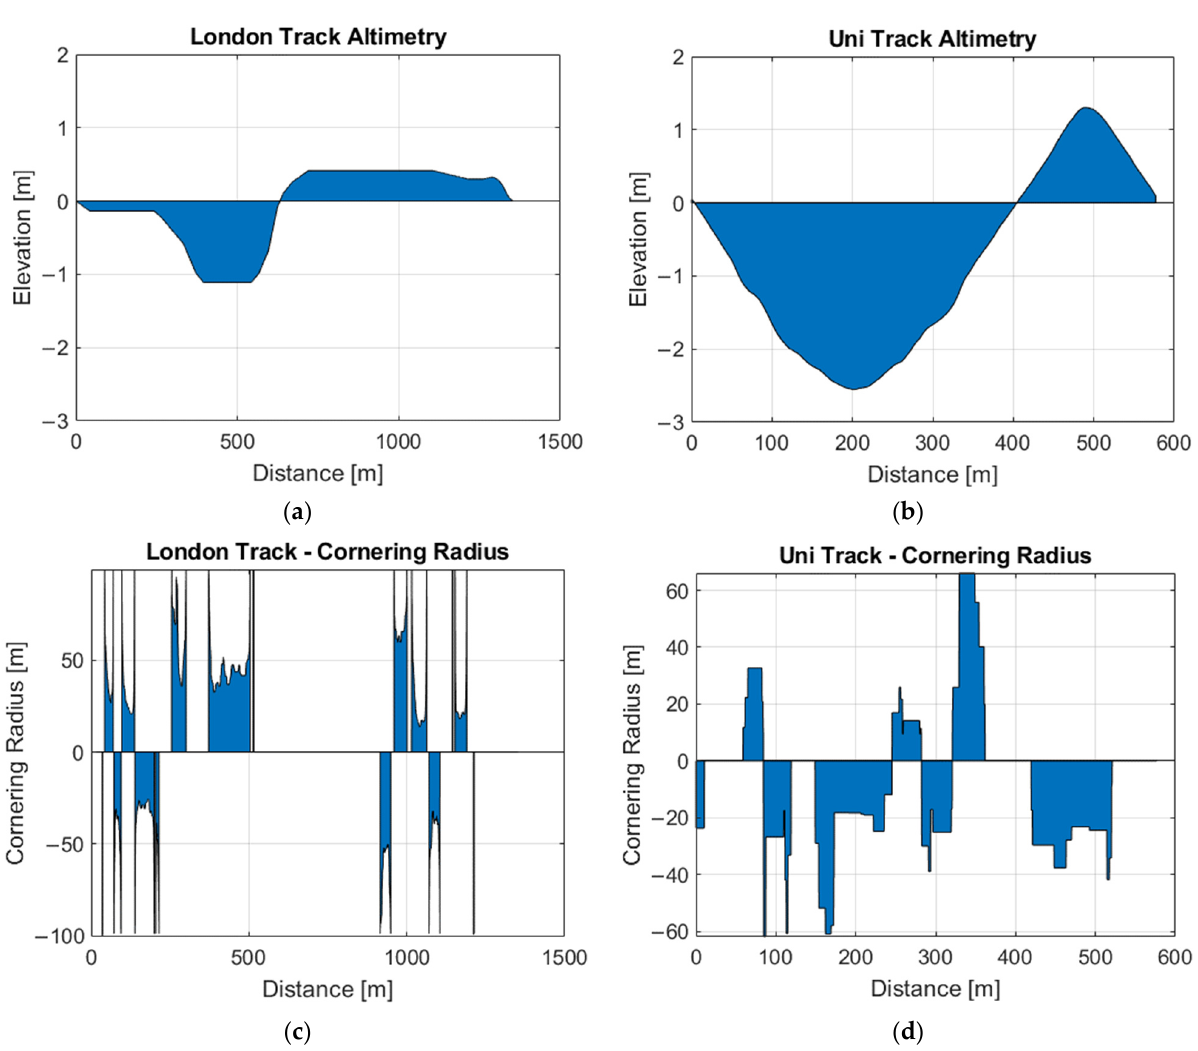
Figure 6. Properties of the investigated track; ( a ) elevation of London Track; ( b ) elevation of Uni Track; ( c ) cornering radius of London Track; and ( d ) cornering radius of Uni Track.